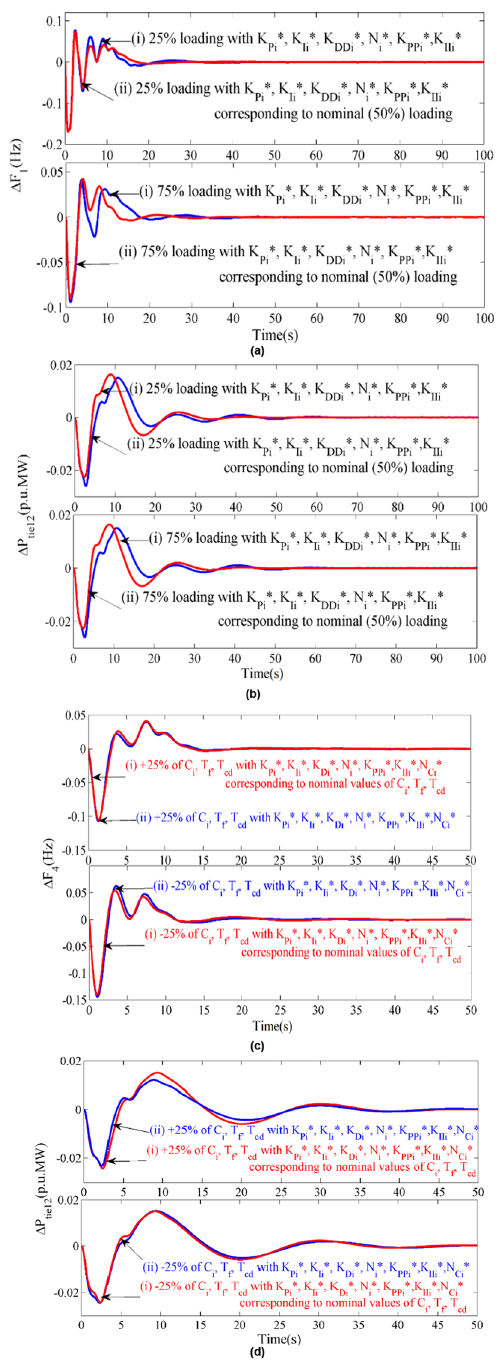
Fig. 7 Comparison of system dynamic responses during 25% ± change in system loading and gas generating unit parameters such as Ci, T f and T cd at the same time. a Frequency deviation in area 1 for 25% change in system loading. b Tie-power deviation in line ± connecting Area1 and 2 for 25% change in system loading. c ± Frequency deviation in Area 4 for 25% change in Ci, T f and T cd at ± the same time. d Tie-power deviation in line connecting Area 1 and 2 for 25% change in C i , T f and T at the same time ±